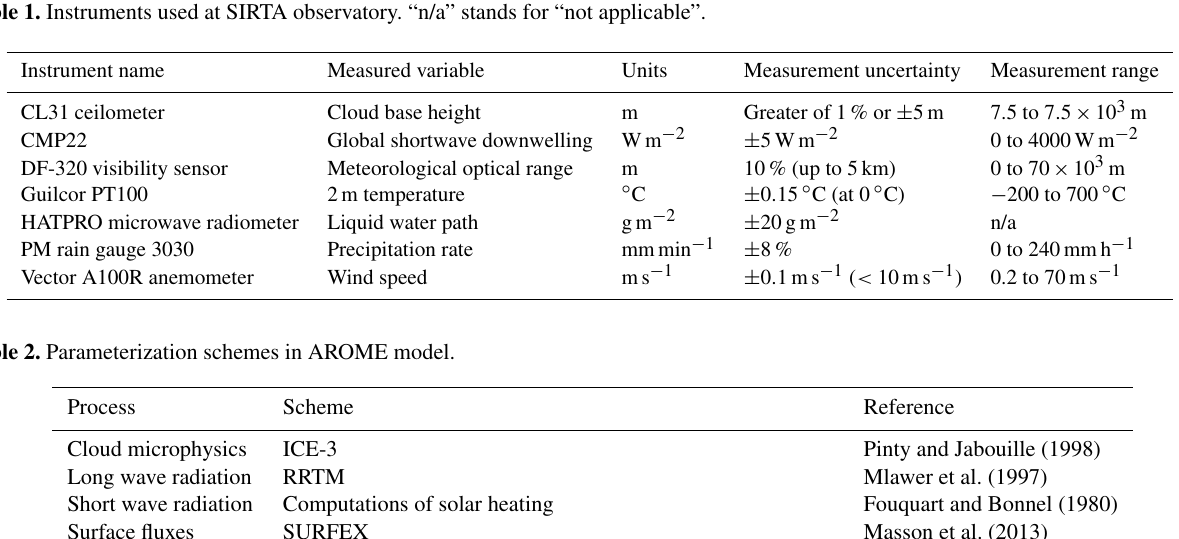
Table 1. Instruments used at SIRTA observatory. “n/a” stands for “not applicable”.